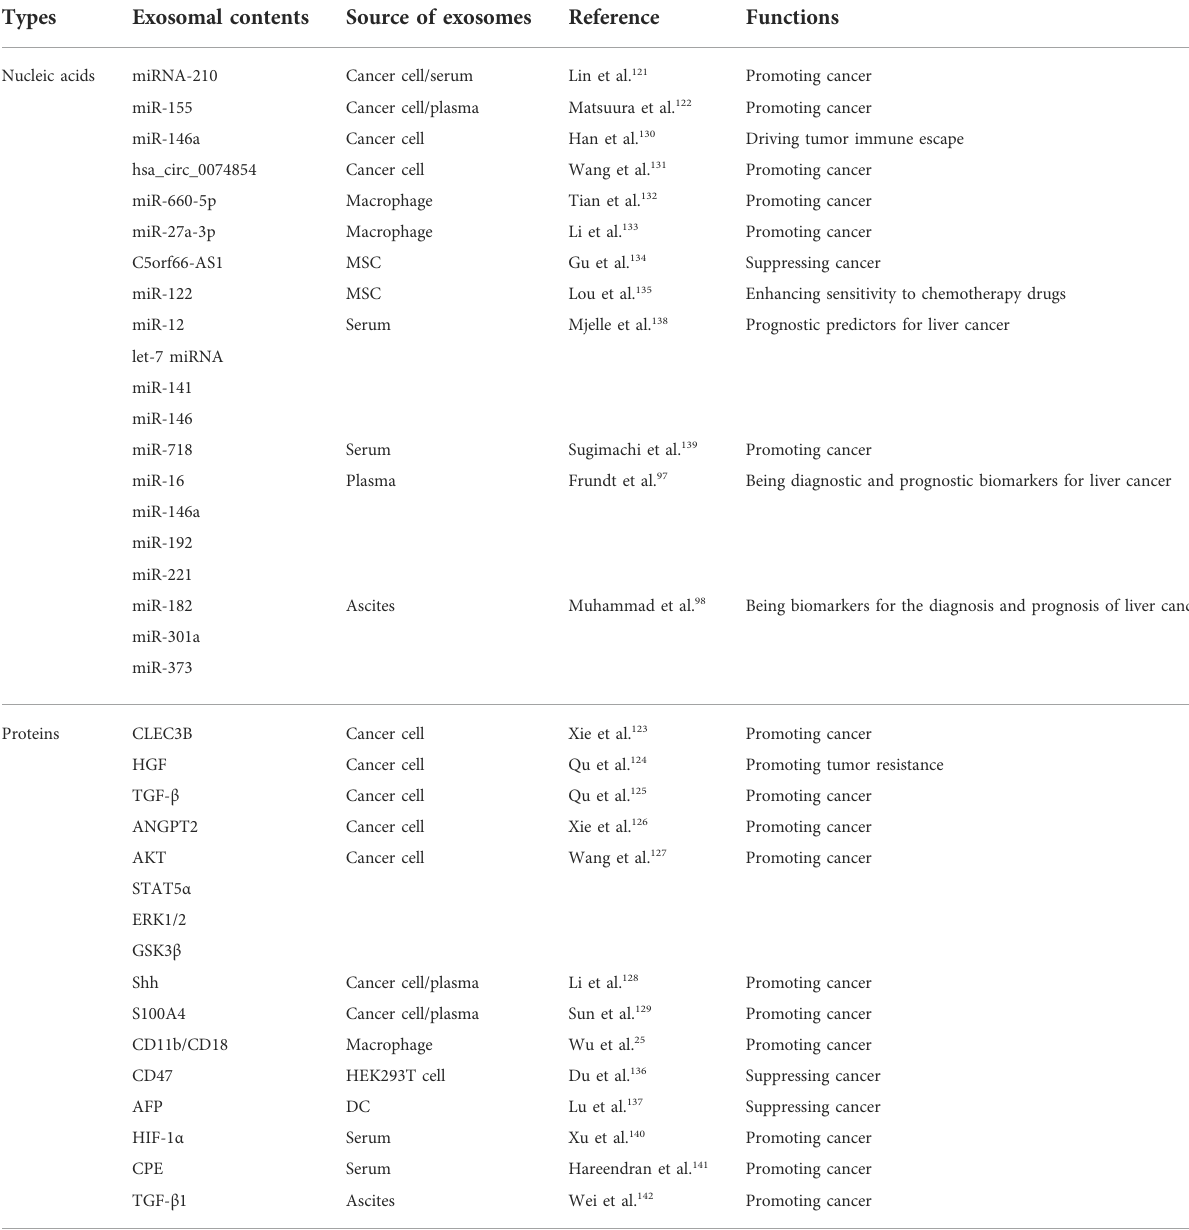
TABLE 5 Function of nucleic acids and proteins carried by exosomes on liver